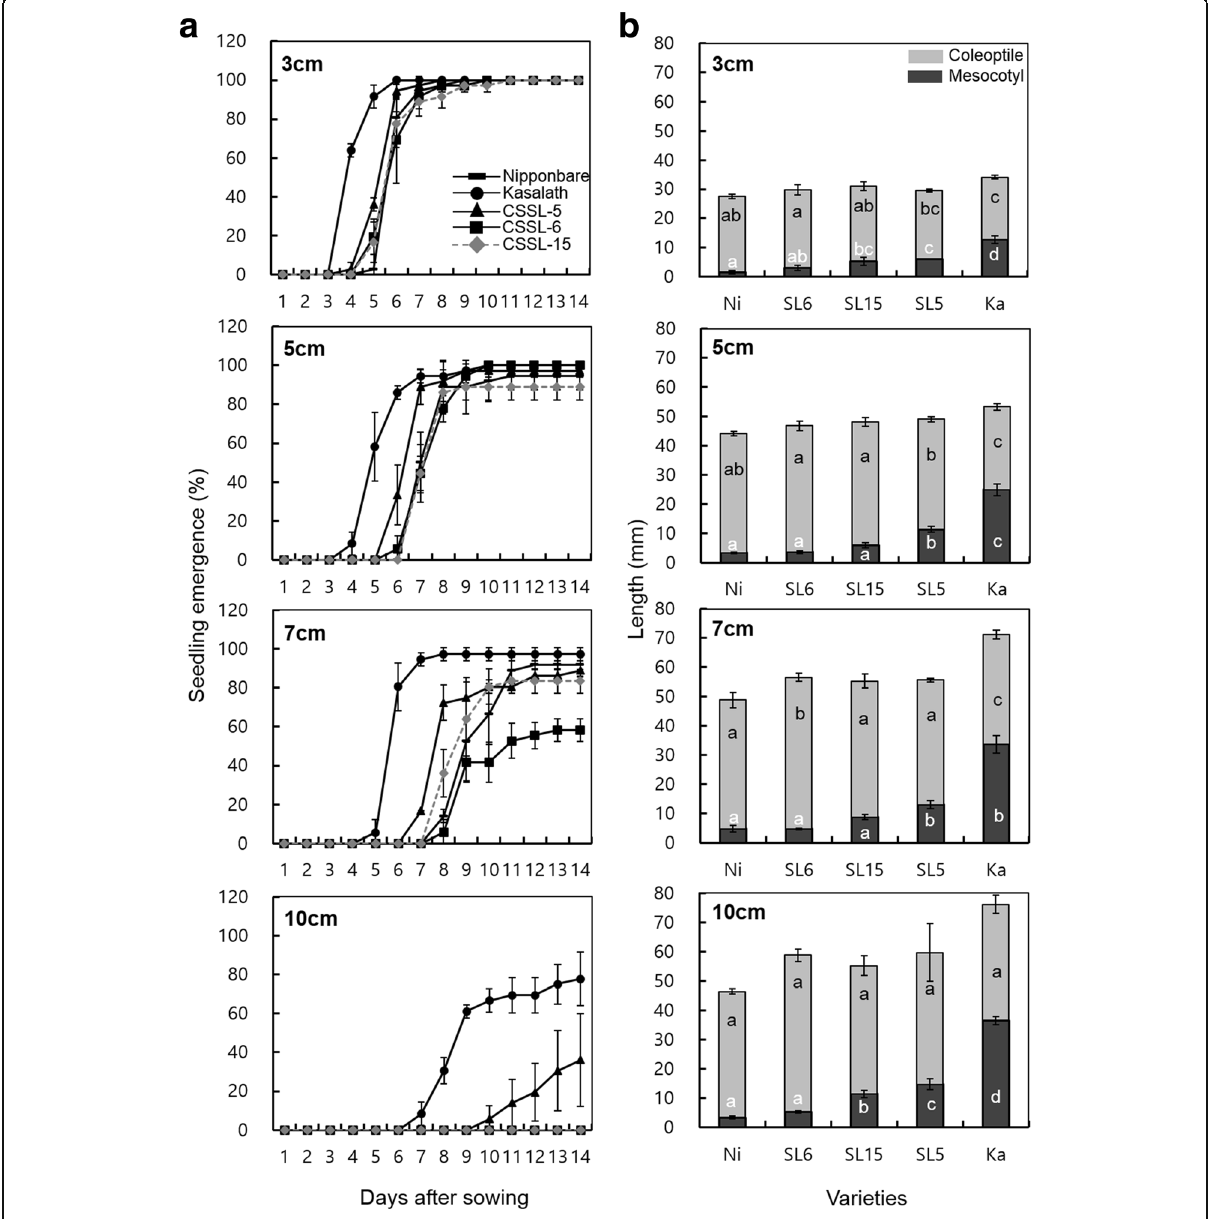
Fig. 5 Time course of seedling emergence ( a ) and mesocotyl and coleoptile length ( b ) of 3 CSSLs, Nipponbare and Kasalath in four soil burial depth; ( a ) Lines and bars represent the mean with SE of 5 lines, Nipponbare(Ni), Kasalath (Ka), CSSL-6 (SL6), CSSL-15 (SL15), and CSSL-5 (SL5). Seeds were sown at 3 cm, 5 cm, 7 cm, and 10 cm soil depth and the number of emerged seedling form soil surface were counted daily up to 14 days after sowing. b At 14 days after sowing, length of mesocotyl and coleoptile were measured. Means of length ± SE ( n = 3) with different letters in the same row indicate significant differences according to the Duncan multiple range test ( P <